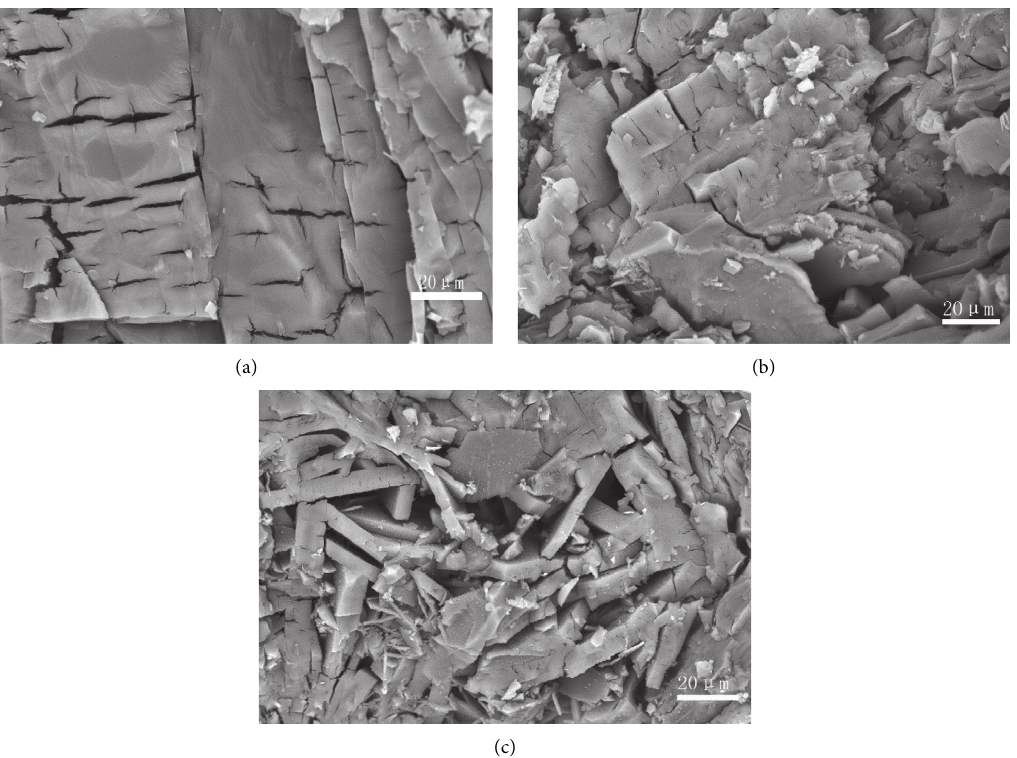
Figure 12: The samples’ microstructure with the M / P ratio of 3:1 cured under three curing conditions for 28 d. (a) Air curing. (b) Standard curing. (c) Water